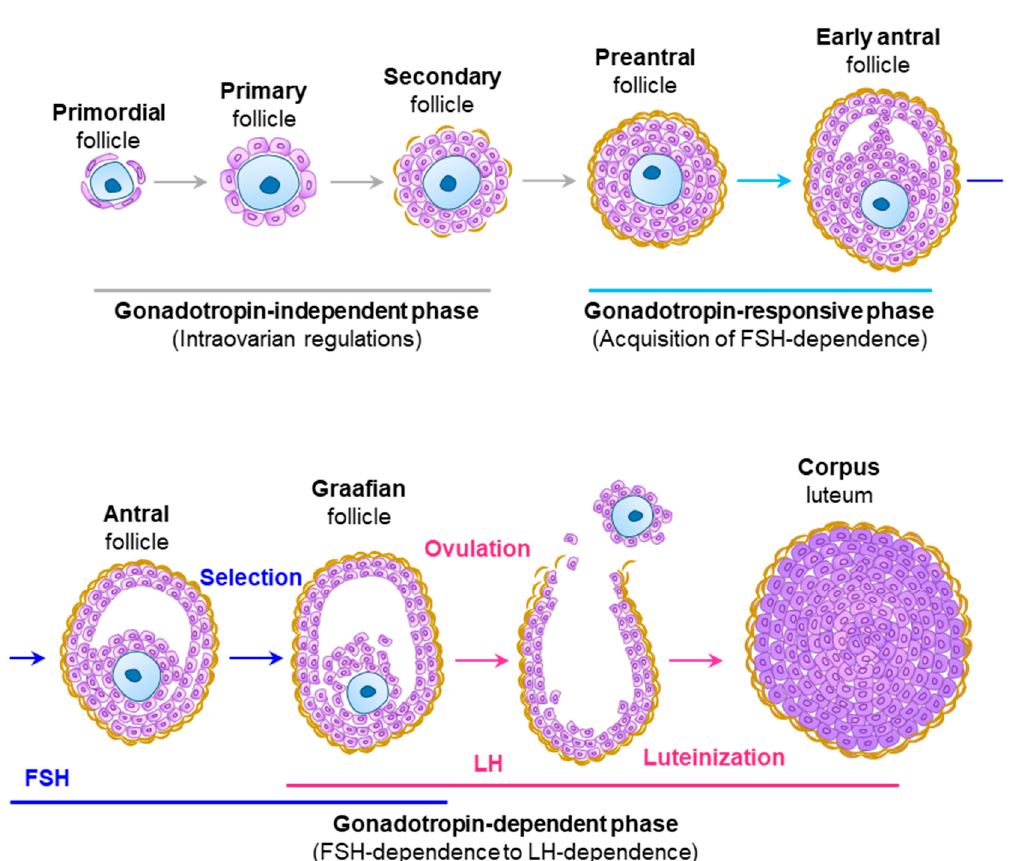
Figure 2. A schematic representation of ovarian follicle development and ovulation. At birth, a fixed number of primor ‐ dial follicles are present in the ovary. Throughout a woman’s reproductive years, follicles are recruited and activated from the pool of dormant follicles. The initial recruitment of primordial follicles to form primary follicles, and their development into secondary follicles are regulated by intraovarian factors, which are independent of gonadotropins. When secondary follicles reach the preantral stage, developmental mechanisms of follicles shift from intraovarian to FSH responsiveness. Subsequent development of preantral follicles to early antral and then antral stage is FSH dependent. Thereafter, follicle selection is accomplished, follicles acquire LH ‐ dependence and LH stimulation gives rise to the development of graafian follicles. LH ‐ signaling is also crucial for the final stages of oocyte maturation, ovulation, and luteinization of GCs. LH and FSH have an identical α subunit, but the β subunit is different in each. This difference is responsible for the specific binding of each hormone to its cognate receptor [52]. However, the receptor binding is not exclusive of the β subunit because the α subunit also interacts with the gonadotropin receptors [52]. As we have mentioned above, only the somatic cells in ovarian follicles express the gonadotropin receptors. TCs express LHCGR and respond to LH stimulation, whereas mural GCs express both FSHR and LHCGR and respond to both gonadotropins [6,53,54]. As oocytes do not express gonado ‐ tropin receptors, the gonadotropin response from TCs or GCs is conveyed to them through vectorial transfer of information [6]. FSHR and LHCGR are G ‐ protein coupled receptors (GPCRs) that activate adenyl cyclase, PKA, PI3K ‐ AKT, and MEK1 ‐ ERK1/2 path ‐ ways. Gonadotropin responses can also be grouped into cAMP ‐ dependent and cAMP ‐ independent. Although both gonadotropins are thought to activate similar protein kinase pathways, the fundamental difference between FSH and LH response in the ovary results from cell ‐ type specific expression of their receptors, and the dynamic differences in their pulsatile and bolus secretion from the anterior pituitary gland.